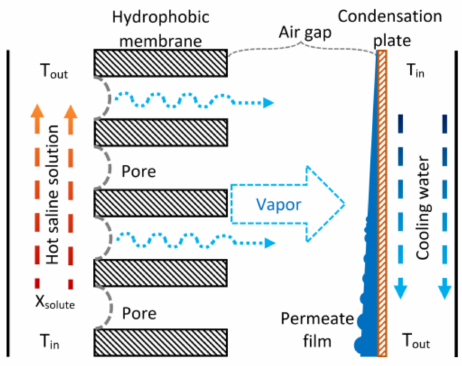
Figure 1. Schematic diagram of the AGMD